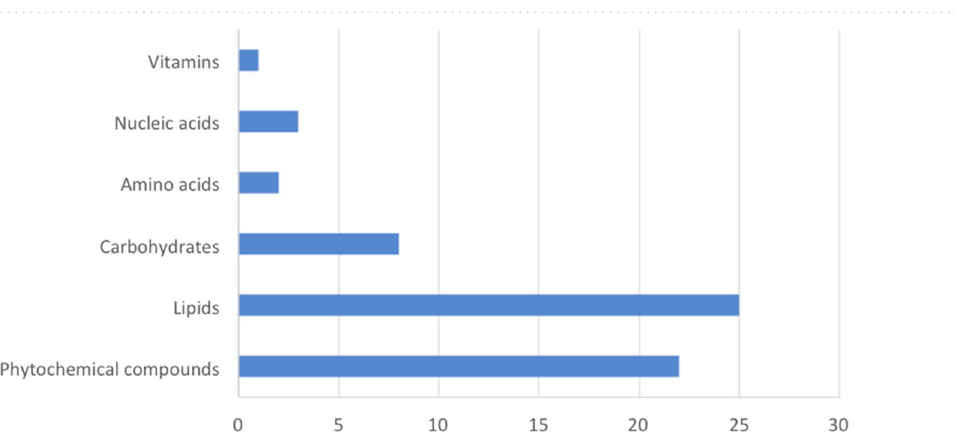
Table 1. Putative identities of the metabolites discriminating mycorrhizal (myc) roots from non-inoculated (cont) roots analyzed by FT-ICR. *VIP > 1 indicates important features discriminating Myc from Cont treatments.